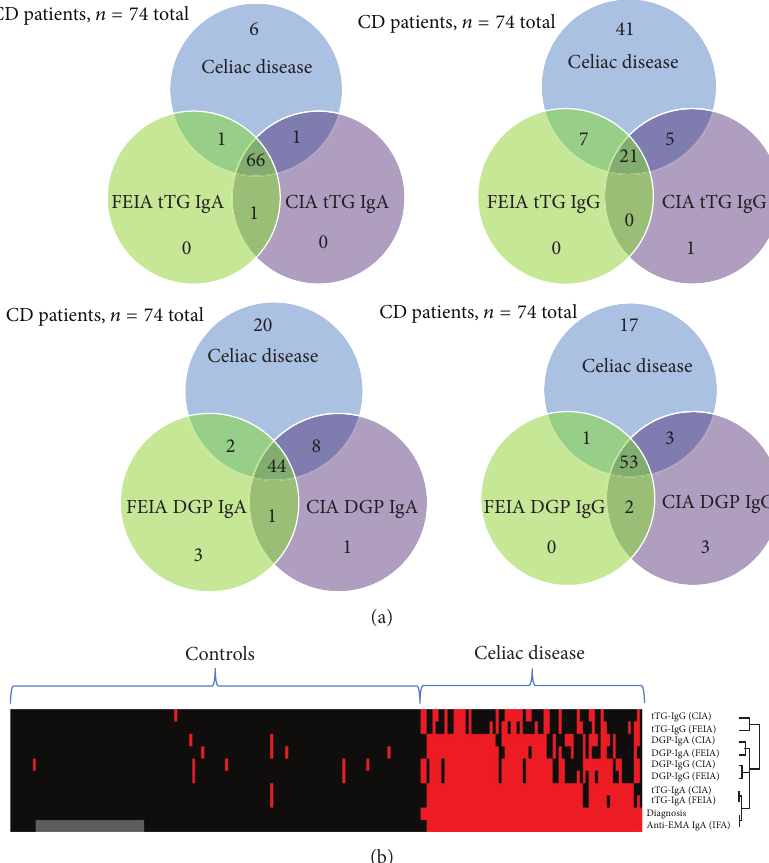
Figure 2: (a) Venn diagram depiction of clinical sensitivity and specificity as well as assay agreement for tTG IgA/IgG and DGP IgA/IgG assays. Upper circle in each group represents all 74 patients with celiac disease and shows presence/overlap of markers (b) Cluster analysis. The cluster analysis shows that the majority of celiac disease patients have multiple positive results. Some of the controls also show positive results by different methods. Isolated vertical lines indicate specimens positive for multiple markers and potentially at increased risk for celiac disease. Red: positive; black: negative; grey: no data